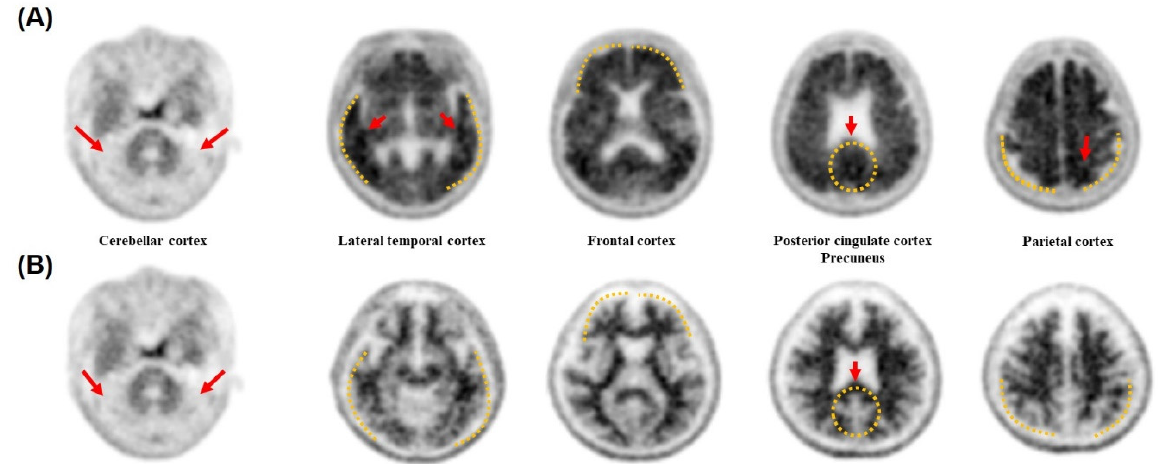
Figure 6. Gray-scale images of fluorine-18 [ 18 F]-florbetaben amyloid PET. ( A ) Typical amyloid PET image of BAPL3. An increased florbetaben tracer uptake was observed not only in the bilateral frontal and parietal cortex, but also in the anterior striatum. The differentiation of the cortical gray matter and subcortical white matter disappeared. ( B ) Typical amyloid PET image of BAPL1. The cortical–subcortical demarcation was well maintained, and no florbetaben tracer uptake was observed in the cerebral cortex.